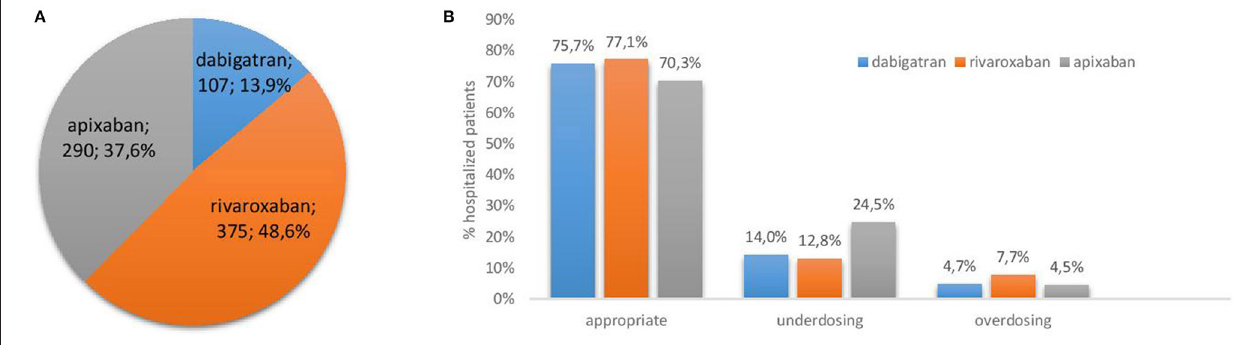
FIGURE 1 | (A) Proportion of admissions where a specific DOAC was administered; (B) Appropriate vs. inappropriate (under-and overdosing) prescribing